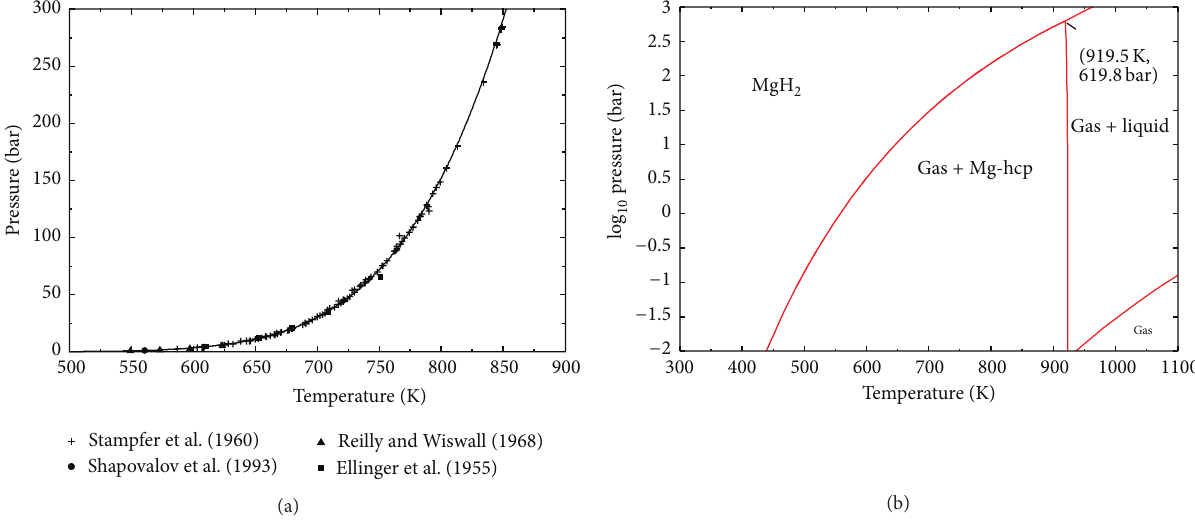
Figure 2: (a) The dissociation pressure of MgH 2 calculated in this work compared to experimental data. (b) Predicted pressure-temperature diagram of MgH 2